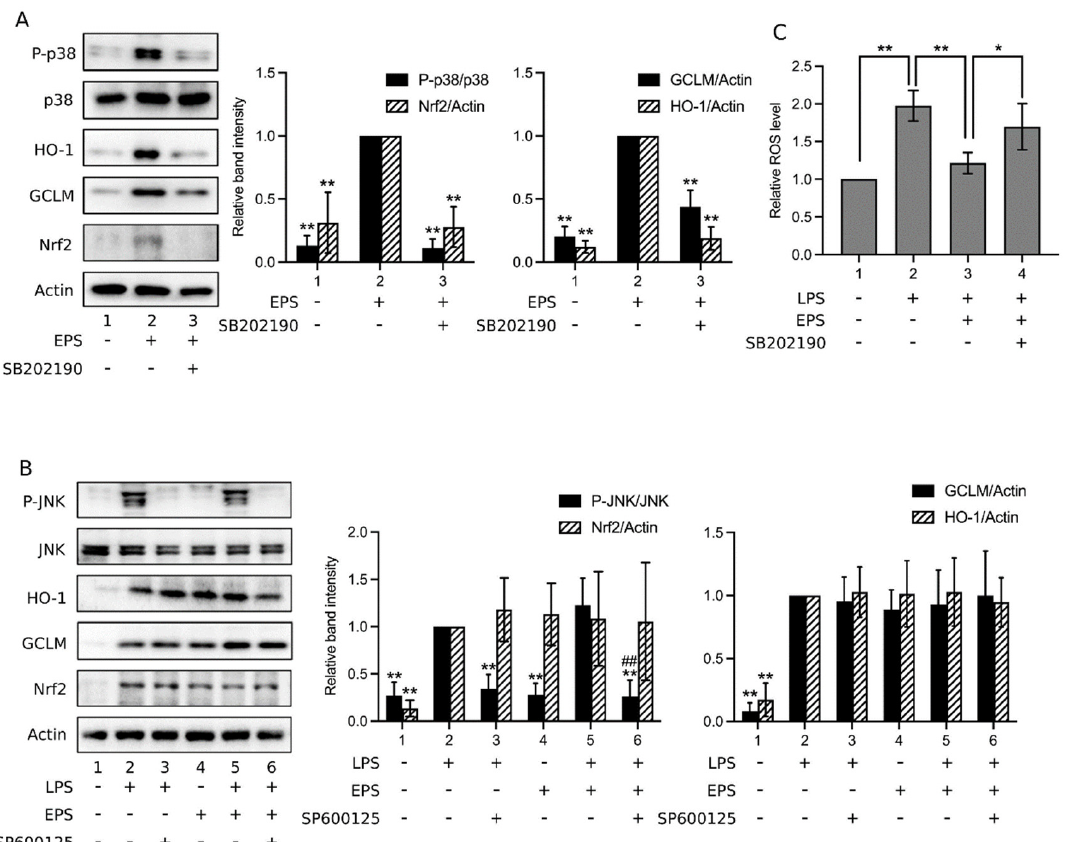
Figure 7. P38 inhibitor but not JNK inhibitor suppressed the activation of Nrf2/HO-1 pathway. ( A , B ) THP-1 cells were treated for 24 h with 1 μ g/mL LPS alone, 100 μ g/mL EPS alone, or the combinations of LPS, EPS, 20 μ M SB202190, or 20 μ M SP600125 (a JNK inhibitor) as indicated underneath the blots. The levels of phosphorylated p38, total p38, HO-1, GCLM, Nrf2, actin, phosphorylated JNK, and total JNK were assayed using Western blotting. Relative band intensity vs. Lane 2 was determined. Data are presented as the mean ± standard deviation of four independent experiments. * p < 0.05 and ** p < 0.005 vs. Lane 2; ## p < 0.005 vs. Lane 5 ( B ). ( C ) THP-1 cells were treated with vehicle (Group 1), 1 μ g/mL LPS (Group 2), LPS and 100 μ g/mL EPS (Group 3), or LPS, EPS, and 20 μ M SB202190 (Group 4) and subjected to intracellular reactive oxygen species (ROS) of three experiments. * p < 0.05 and ** p < 0.005 between the indicated